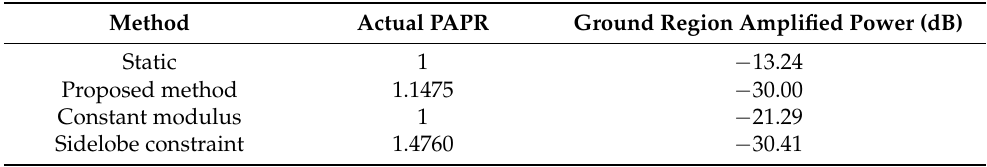
Figure 3. Comparison of weighted vectors. Table 2. Region amplified power improvement and